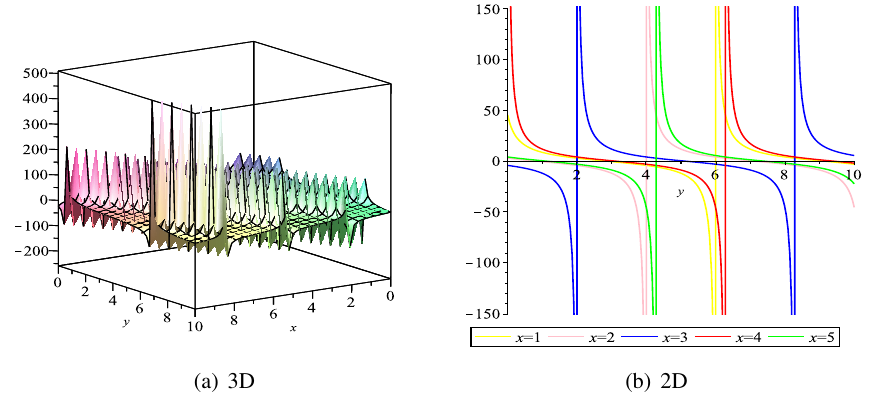
Fig. 4 The singular periodic solution (69) for k 1 = 1 , k 2 = 0 . 5 , k 3 = 1 . 5 , c 2 = 2 , δ = − 0 . 5 , α = 1.